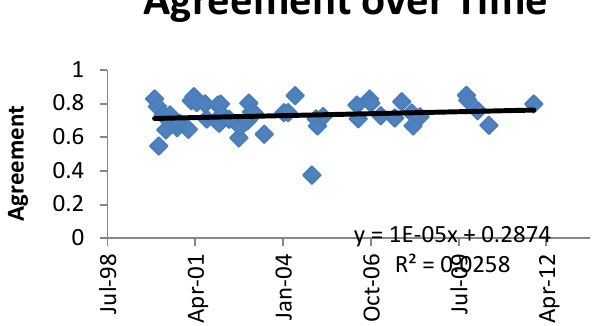
Figure 18. Overall agreement ( i.e. , total agreement at the level of individual study dates)